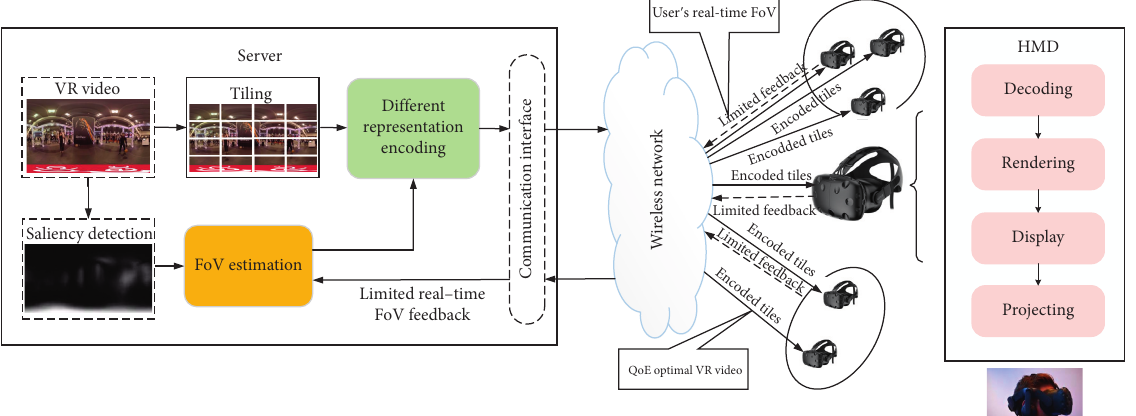
Figure 2: Panoramic video streaming system based on limited FoV